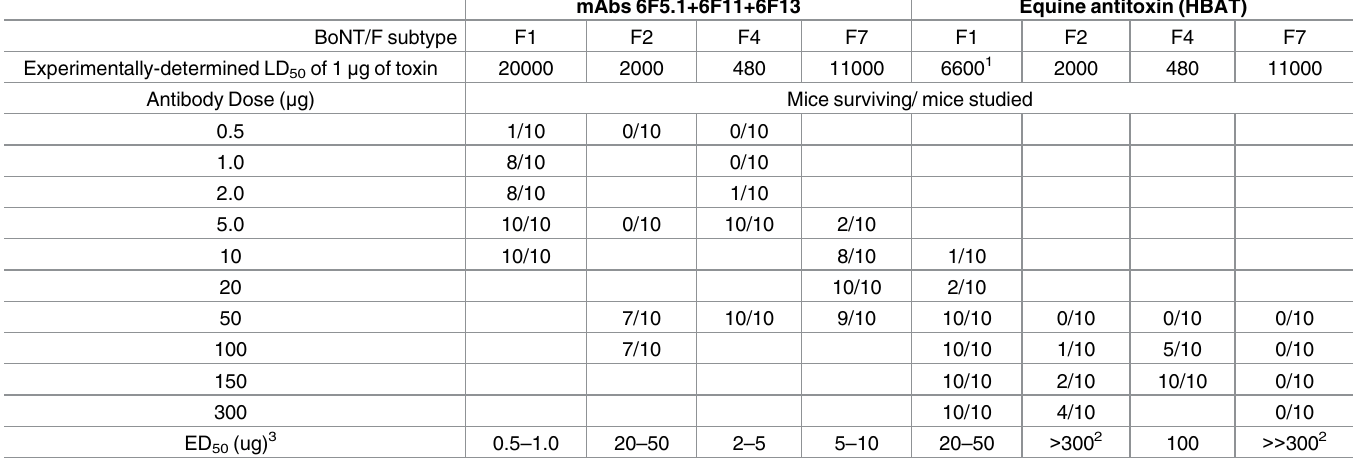
Table 4. Neutralization of BoNT/F subtypes in the mouse neutralization assay by HBAT of an equimolar combination of mAbs 6F5.1, 6F11 and